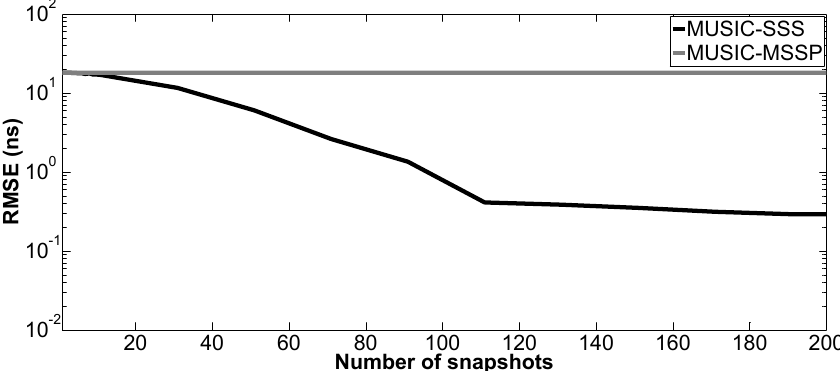
Figure 11. RMSE on the estimated time delay ˆ t M 1 versus the number of snapshots.